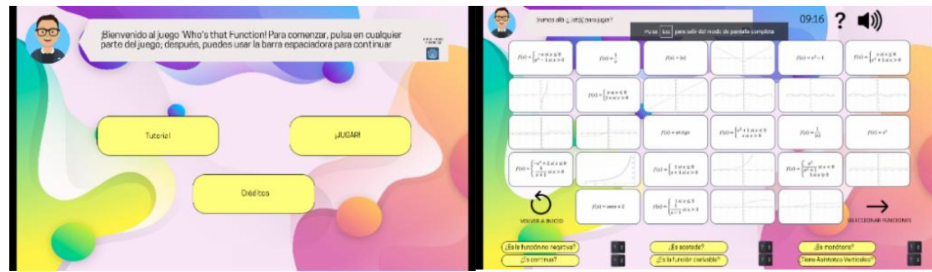
Figure 7. Screenshots of the online